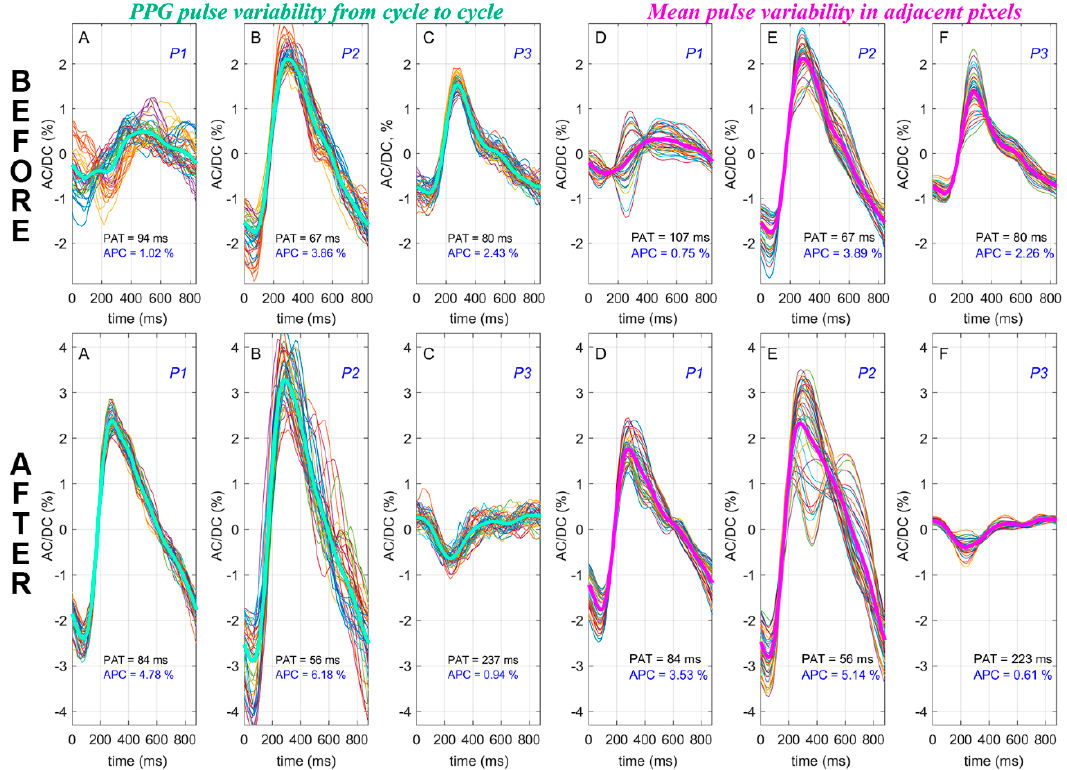
Figure 2. Variations of the photoplethysmography (PPG)-pulse shape in time and space in the case of a tumor: Thin color lines in ( A – C ) show PPG pulses of 43 consecutive cardiac cycles calculated in the central pixel of a region of interest (ROI) marked by P1, P2, and P3, respectively. The positions of these ROIs in the cortex are shown in Figure 1. Thick green lines in these graphs are PPG pulses averaged over the cardiac cycles. The thin color lines in graphs ( D – F ) show the mean PPG pulses calculated in each of 49 neighboring pixels within respective ROIs marked by P1, P2, or P3. The thick pink lines in these graphs are the waveforms averaged over all pixels within the ROI. The upper and lower rows show the graphs before and after surgery, respectively.